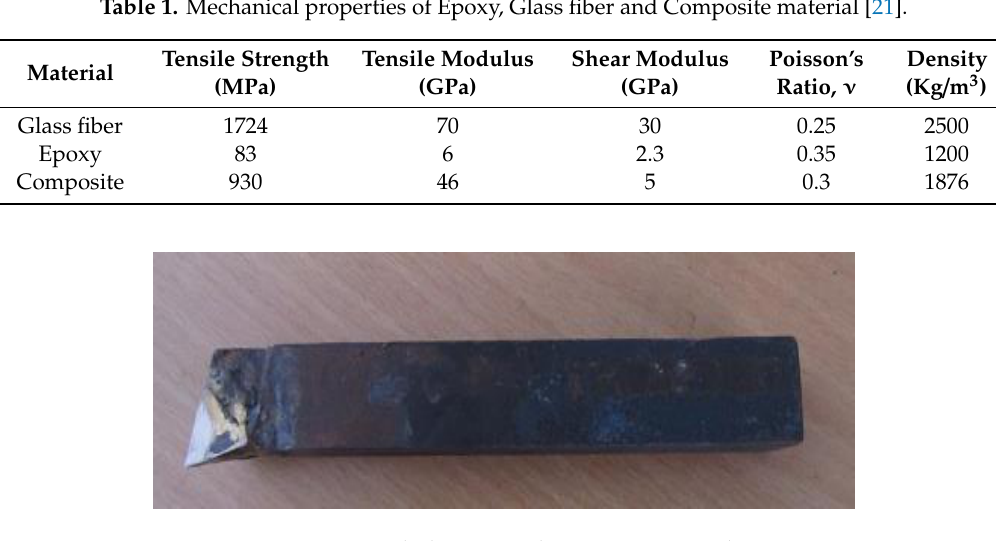
Figure 3. Carbide K10 single point cutting tool. Table 2. Composition and properties of Carbide K10 tool [22].